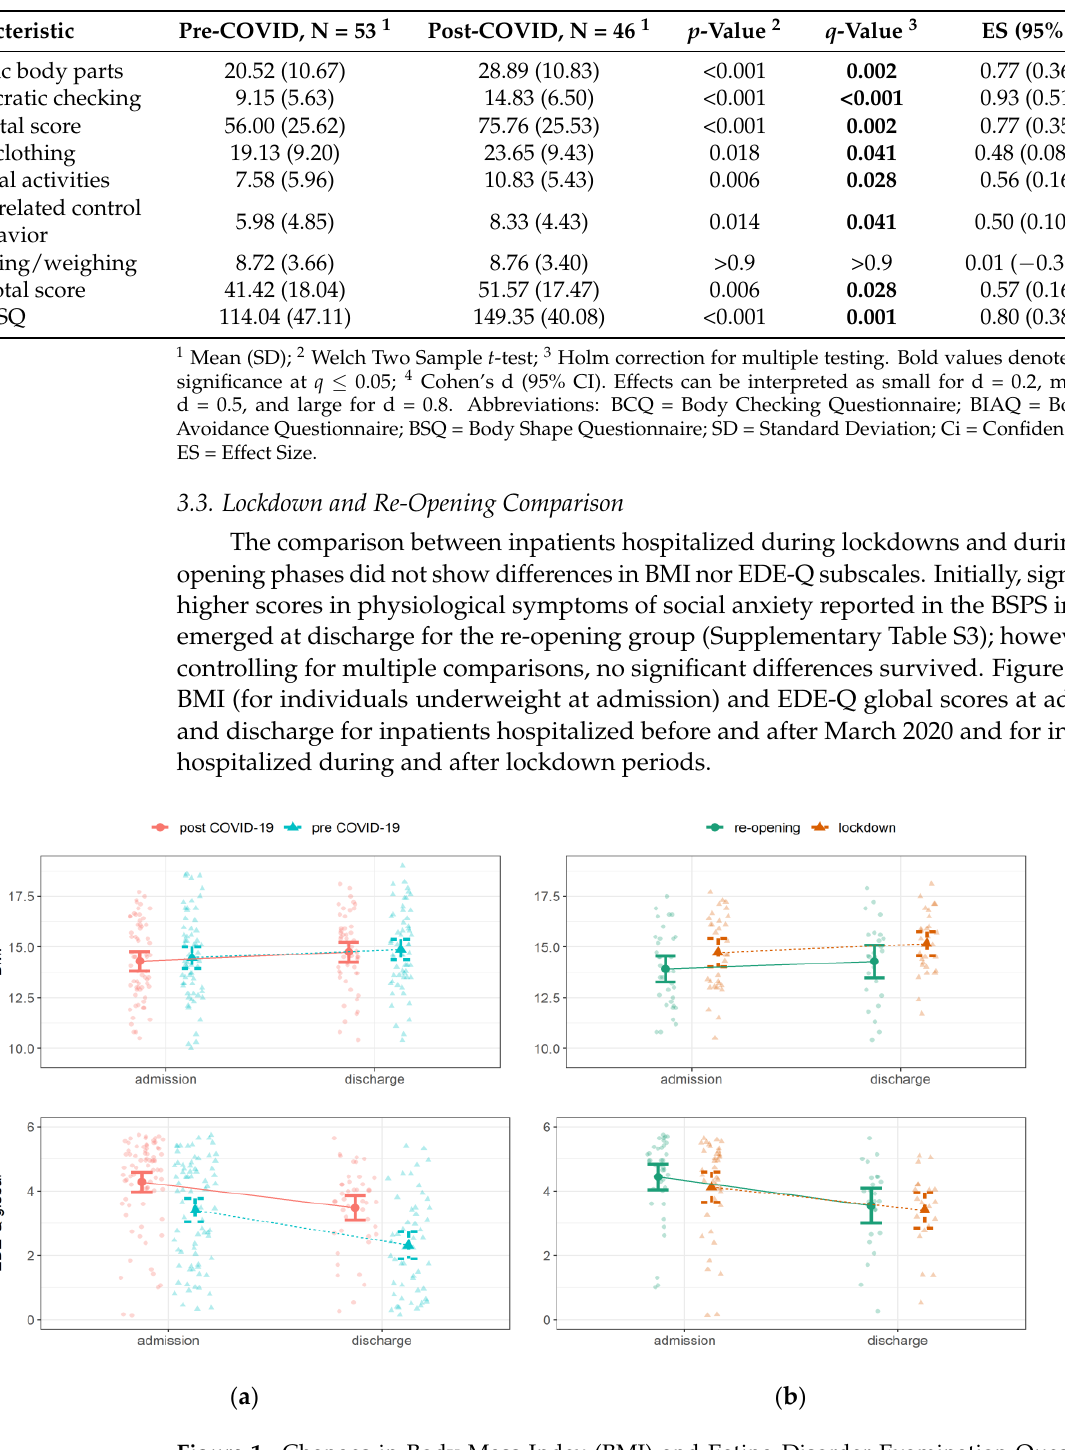
Table 2. Comparison of body specific psychopathological measures between individuals hospitalized before and after the start of the COVID-19 pandemic.